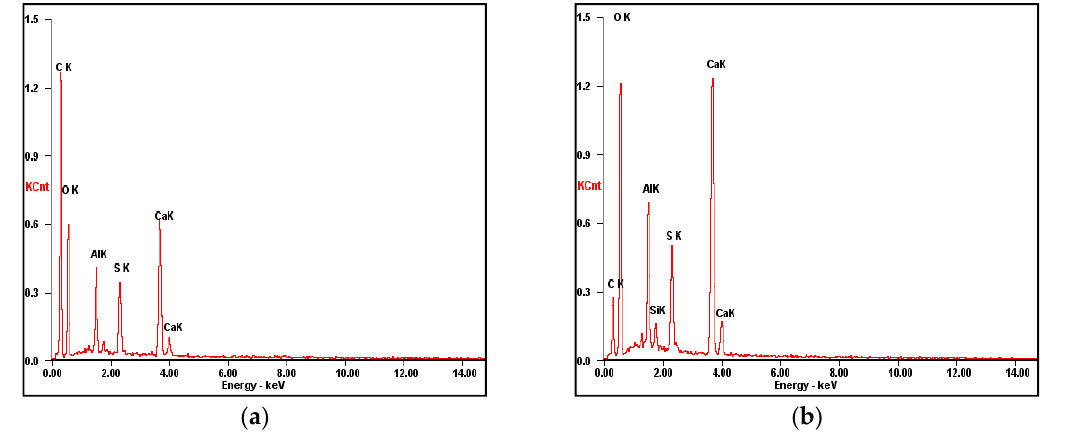
Figure 8. Energy spectrums of slurry from Figure 7a “3” ( a ) and Figure 7c “4” ( b ); ( a ) EDS from Figure 7a; ( b ) EDS from Figure 7c.